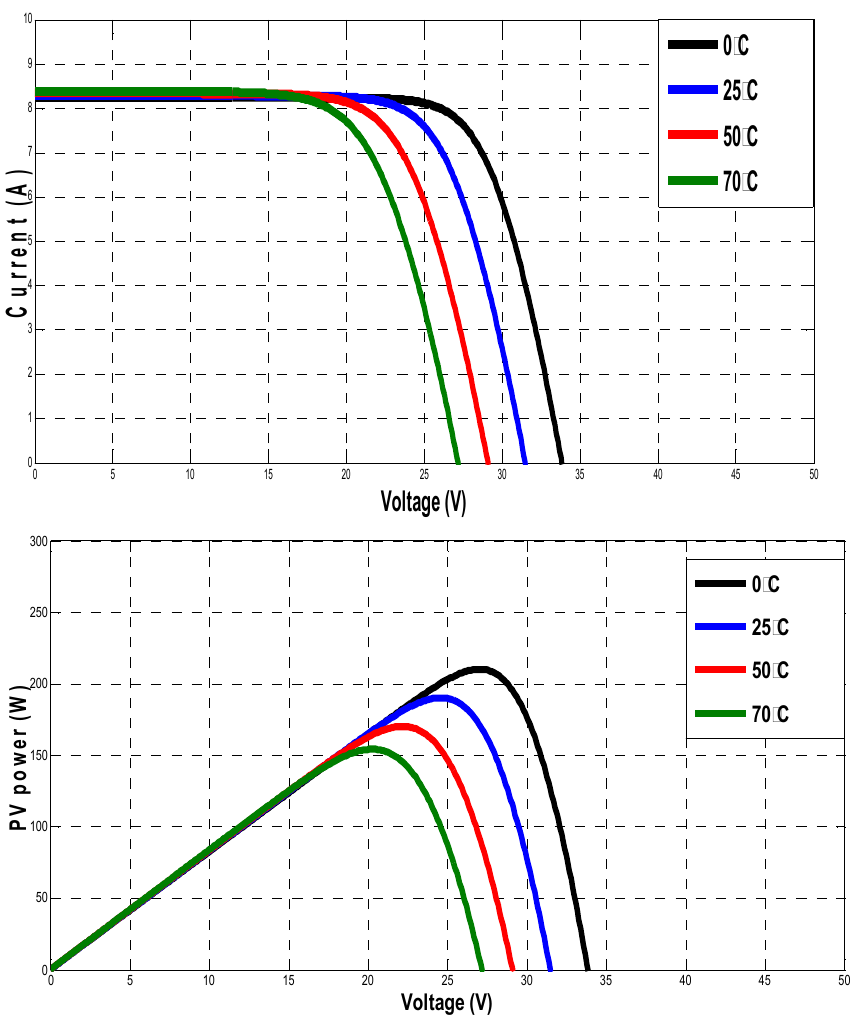
Figure 9. Electrical characteristics of the Sun module SW 250 mono panel for different temperatures.